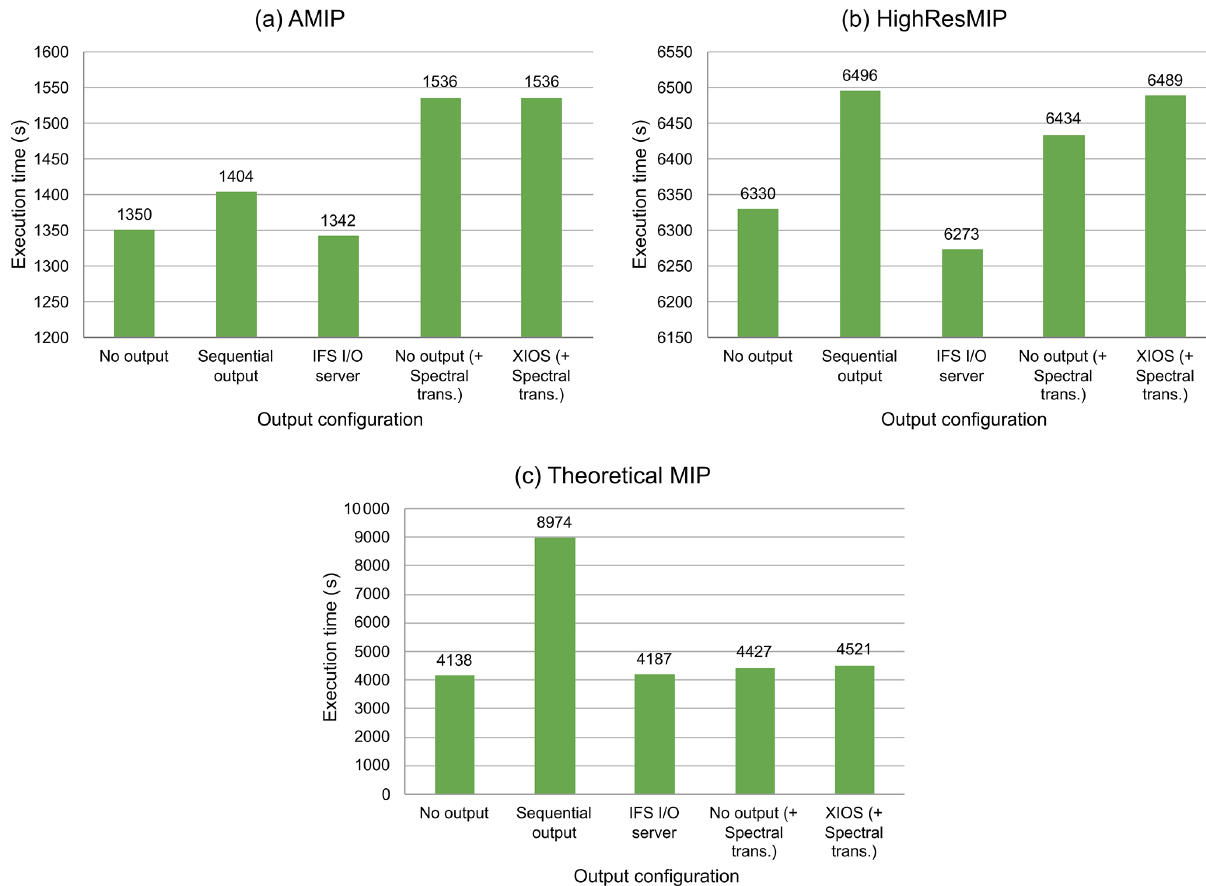
Figure 6. Comparison of the execution time of different output schemes for the three configurations